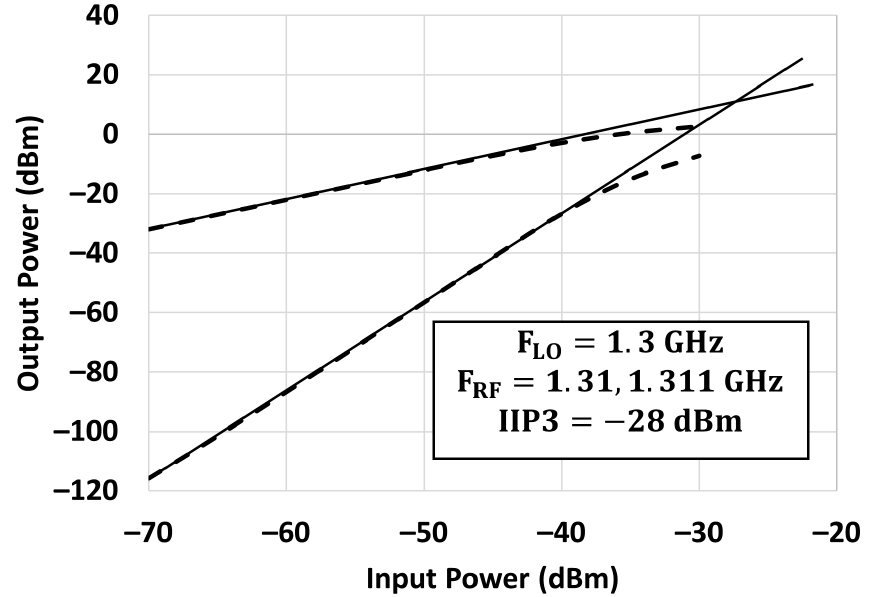
Figure 15. The post-layout simulated fundamental and third-order intermodulation products versus the input power.